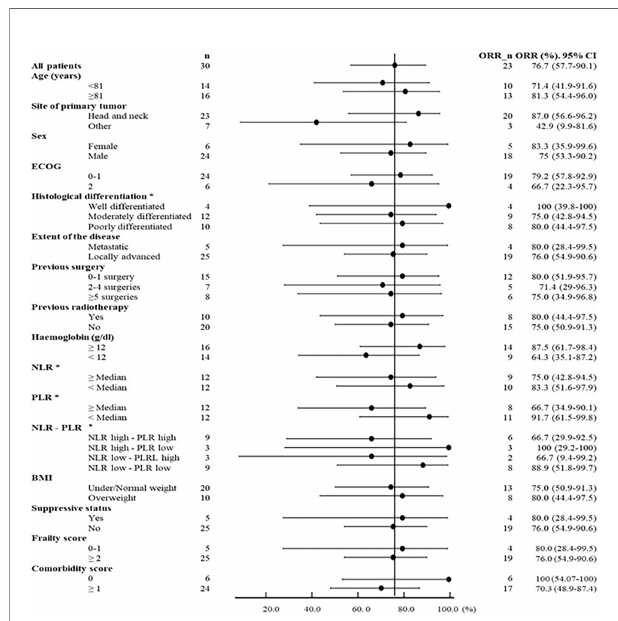
FIGURE 3 | Forest plot of response in selected subgroups of patients according to the main clinical and hematological characteristics. For hematologic parameters, we considered pre-therapy values: only 24 patients were considered eligible (three patients were excluded for concomitant hematological tumors, one for thalassemia major, and two patients for concomitant immunosuppressive therapy).